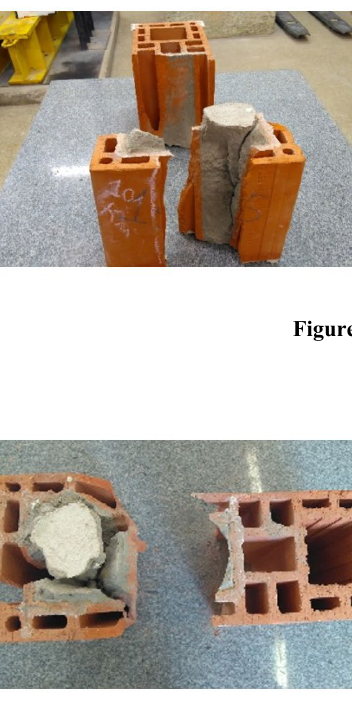
Figure 12. BV10 specimens after push-out